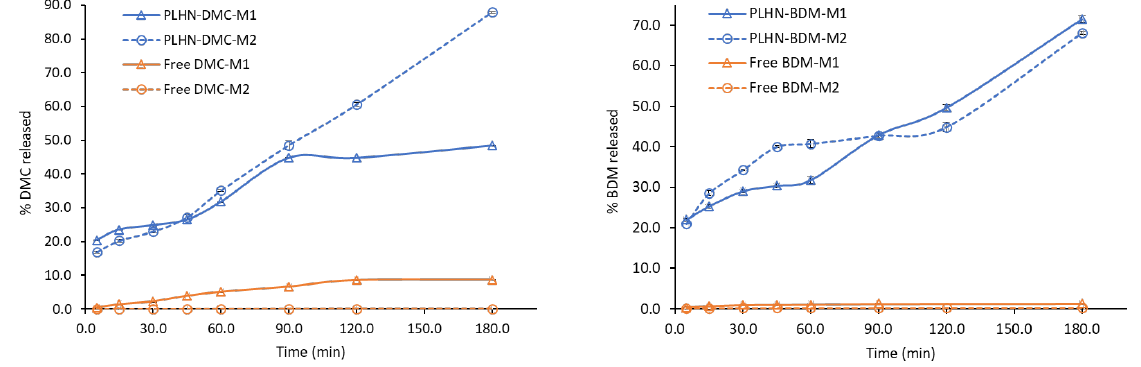
Figure 7. Release profile of DMC and BDM from the PLHNs compared with free DMC and BDM dissolution rate in two dissolution media. Error bars represent the standard deviation of DMC and BDM concentration in the triplicates.